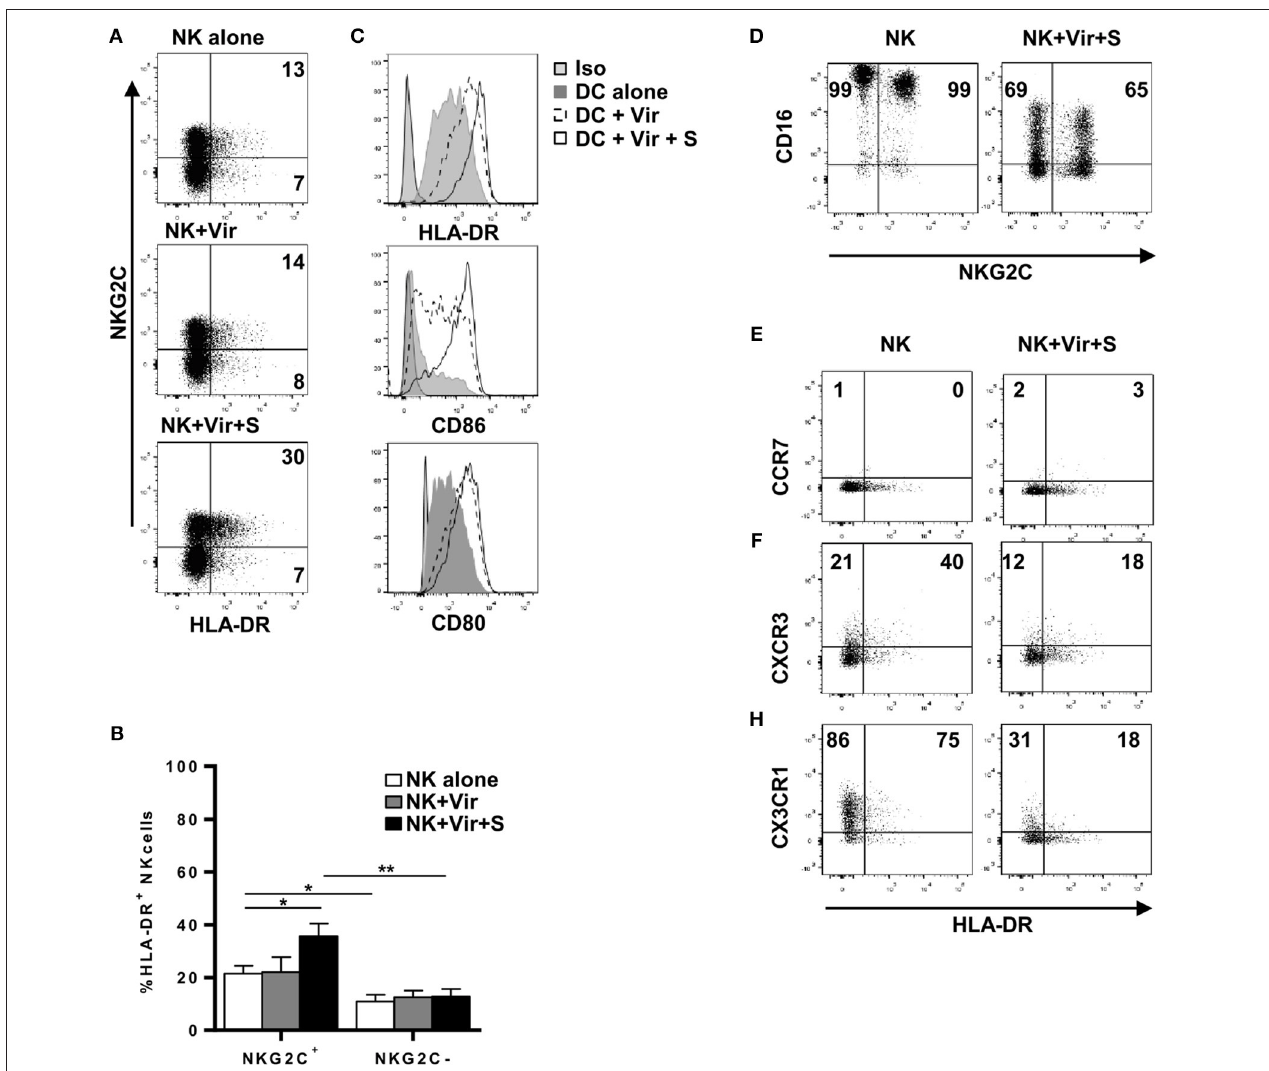
FIGURE 3 | NKG2C bright NK cells up-regulate HLA-DR upon HCMV antigen uptake in the presence of specific antibodies. NK cells and moDC were cultured 20h with HCMV viral particles in the presence or absence of serum from HCMV + donors. Expression of HLA-DR, CD86, CD80, CD16, CCR7, CXCR3, and CX3CR1 was analyzed by flow cytometry. (A) Dot plots of HLA-DR and NKG2C expression in NK cells in the indicated conditions. Inset numbers indicate the frequency of HLA-DR + cells in NKG2C + and NKG2C- NK cells. Data from a representative donor out of four studied. (B) Bar graph showing the average expression of HLA-DR in NKG2C + and NKG2C– NK cells in the different conditions (mean ± SEM, n = 4) (* p < 0.05, ** p < 0.01). (C) Histograms displaying HLA-DR, CD86, and CD80 expression in moDC in the indicated conditions. (D) Dot plot showing CD16 and NKG2C expression in NK cells incubated or not with HCMV virions and specific serum. Inset numbers indicate percentages of CD16 + cells in NKG2C + and NKG2C- NK cells. (E–H) Dot plot showing CCR7, CXCR3, and CX3CR1 in HLA-DR + and HLA-DR- NK cells incubated or not with HCMV virions and specific serum. Data from one donor out of three analyzed are shown. Inset numbers indicate percentages of cells positive for each chemokine receptor in NKG2C + and NKG2C- NK